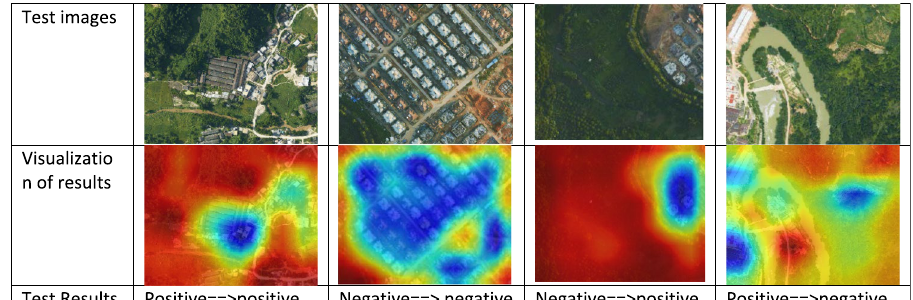
Fig. 14 Examples of the image classification algorithm’s recog- nition results visualization